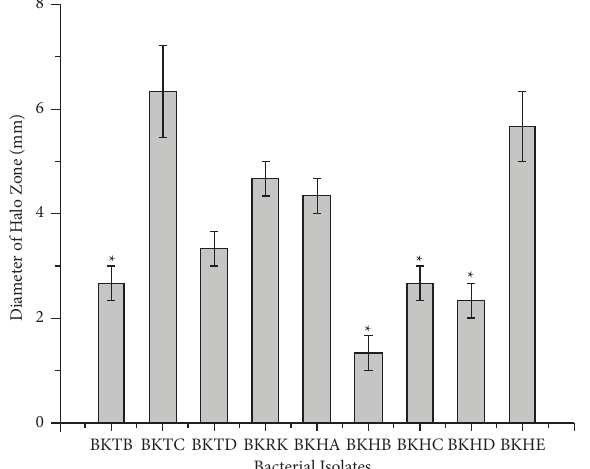
Figure 2: Comparison of halo zones in sodium caseinate agar by diferent bacterial isolates. ∗ Te mean diameter of the halo zone is signifcantly lower in comparison with the mean value of BKTC at α � 0.05. Table 1: Results of hemolytic activity and hydrolytic enzymes.